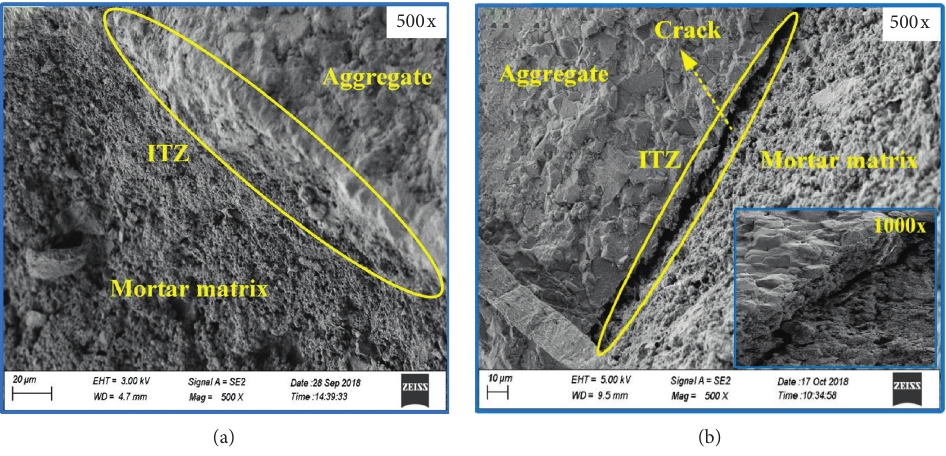
Figure 10: Typical SEM images of ITZ section. (a) AWJ impact; (b) PWJ impact.